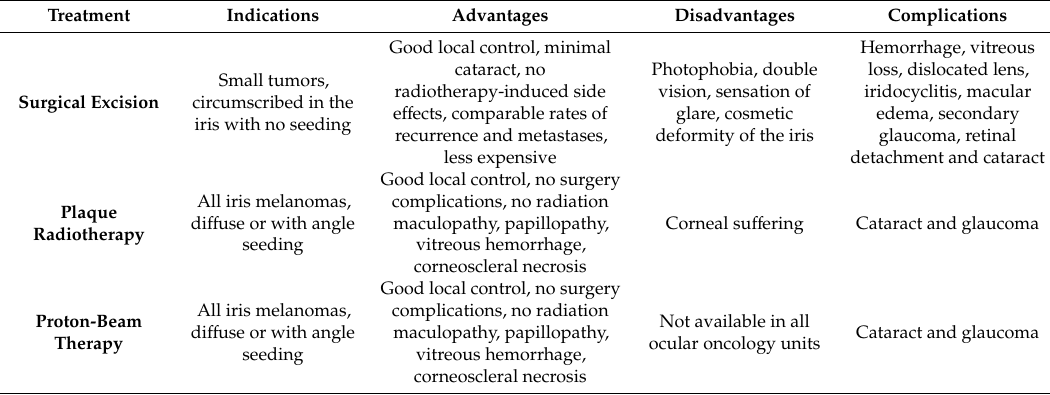
Table 1. Advantages and disadvantages of various strategies with possible